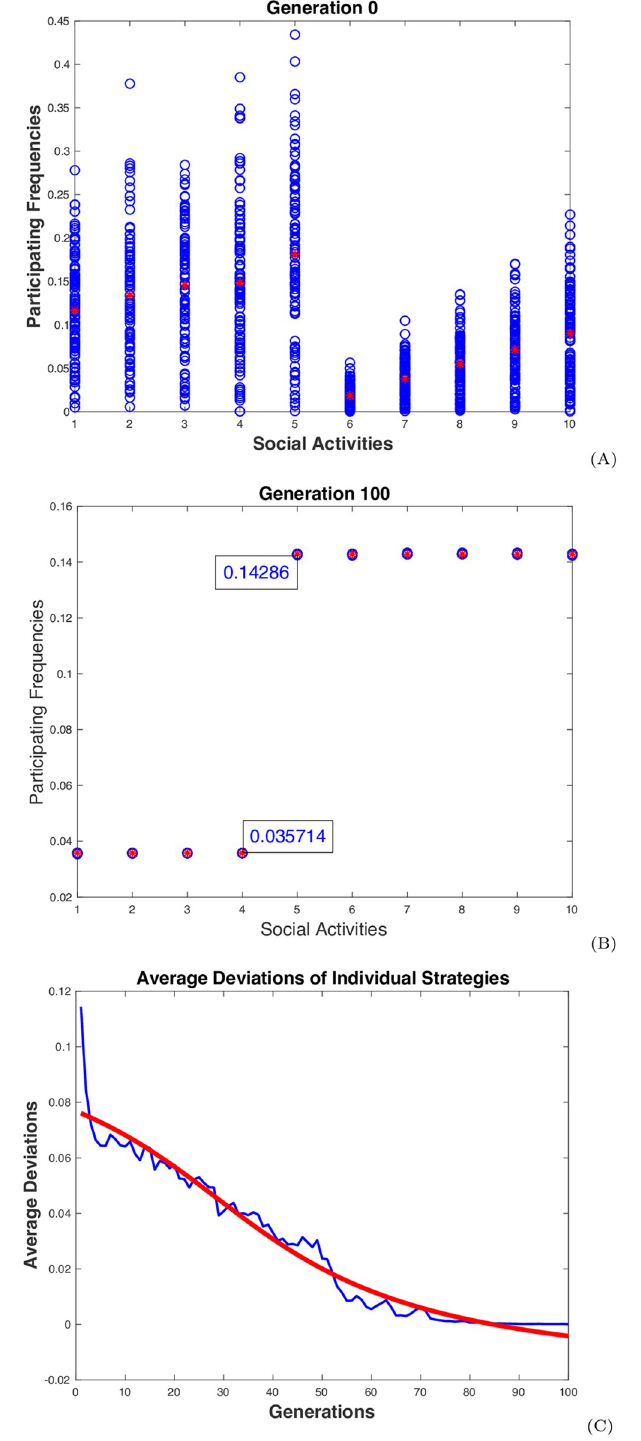
Fig 3. Dynamic behaviors of the distancing population. The simulation results from a typical test run for a population of 100 individuals with 10 independent activities are displayed: The graphs (A) and (B) show the initial and final distributions of the individual frequencies over the 10 activities. The activities are listed on the x -axis. The frequencies are displayed in blue circles, one for one individual on one activity. The red stars represent the average frequencies of the population. The blue curve in graph (C) shows the changes of the averaged RMSD of the individual frequencies over generations. The red curve is a smoother regression showing the general trend of the changes.